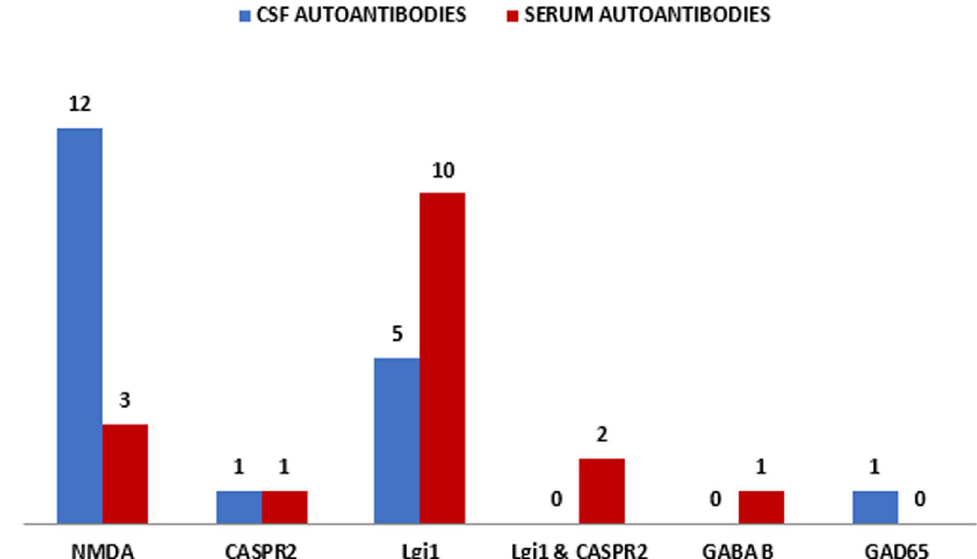
Fig. 2 Auto-antibody distribution in CSF and serum samples for AE